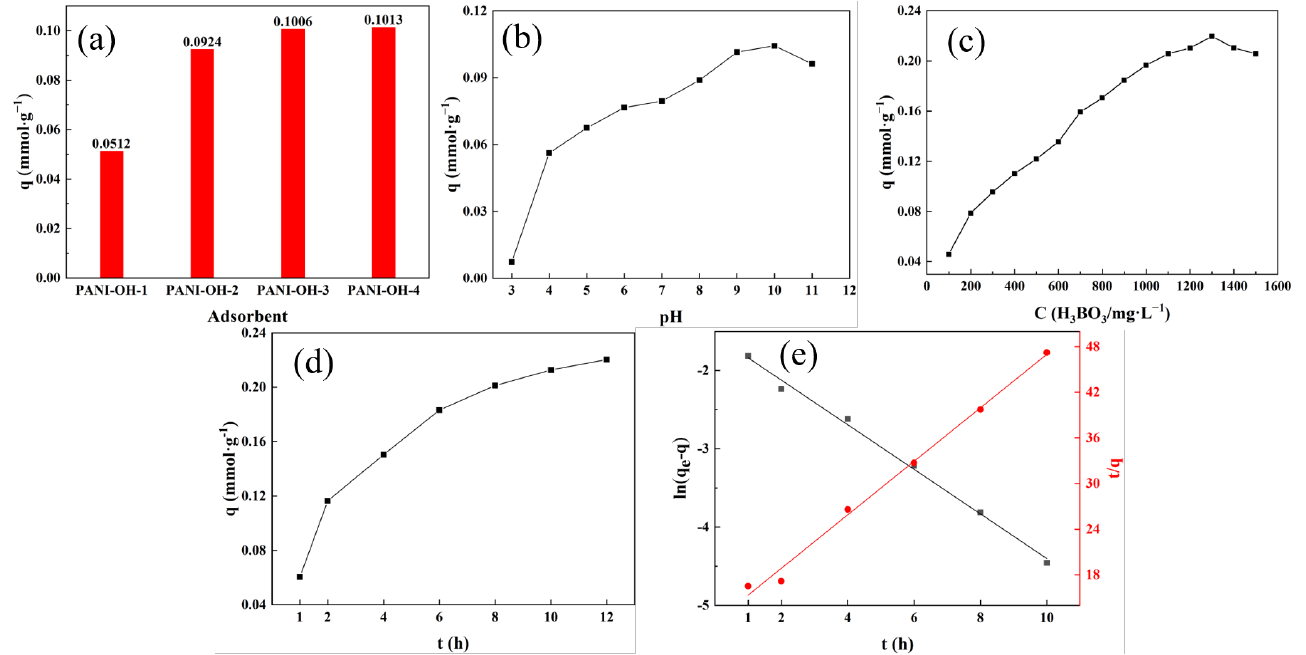
Figure 4. The effect of ( a ) glycidol content (pH = 9, C 0 = 600 mg/L, t = 10 h, T = 298 K); ( b ) pH (C 0 = 600 mg/L, t = 10 h, T = 298 K); ( c ) C 0 (pH = 10, t = 10 h, T = 298 K); ( d ) t (pH = 10, C 0 = 1300 mg/L, T = 298 K) on the adsorption capacity; (e) adsorption kinetics fitting.